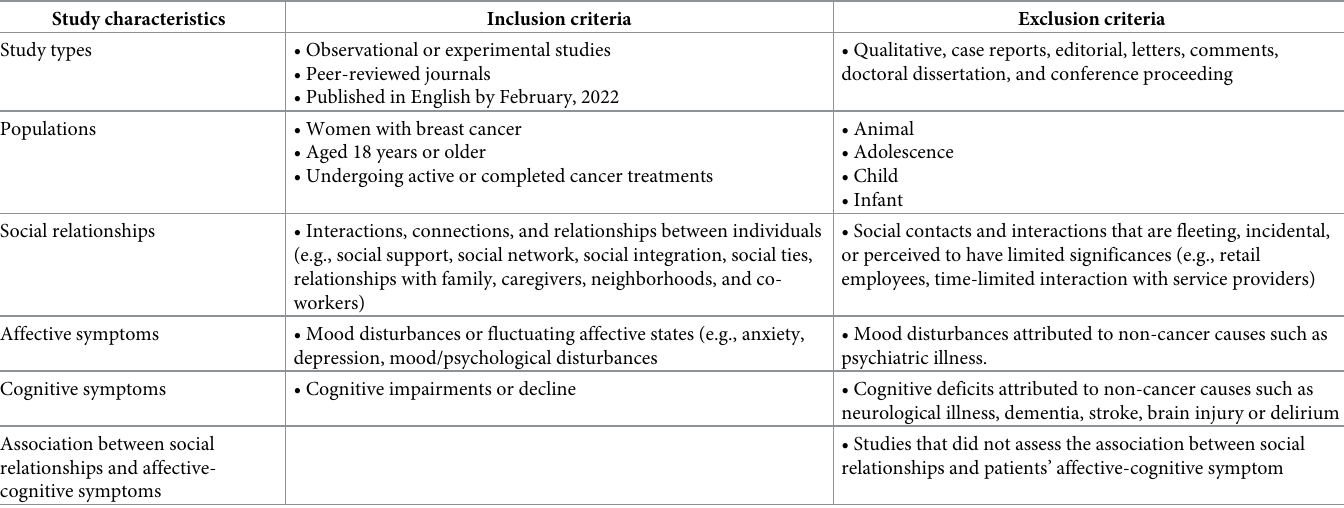
Table 1. Inclusion criteria and exclusion